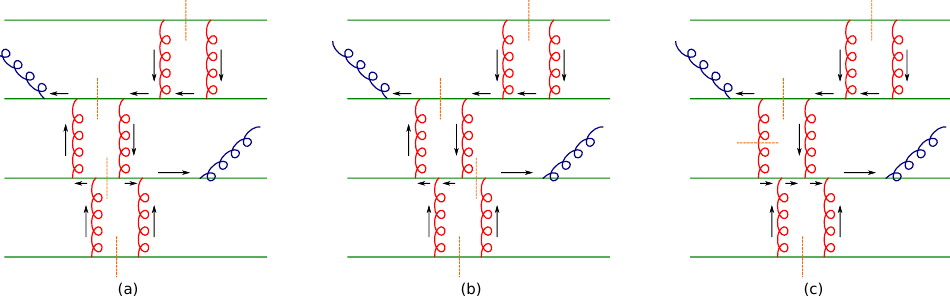
Figure 7 . Illustration of diagrams in the classical limit. Diagrams (a) and (b) are separated into a product of two sub-diagrams connected to each other by S (0) cut quark propagators. Each of 22 the sub-diagrams contributes to the classical (cid:12)eld. In contrast, diagram (c) does not have such a separation. However, it is canceled in the eikonal approximation. Here, each orange dashed line crosses a quark 2 (cid:0) 2 propagator indicating that the quark is on mass-shell and each retarded Green function is associated with an arrow pointing in the increasing time